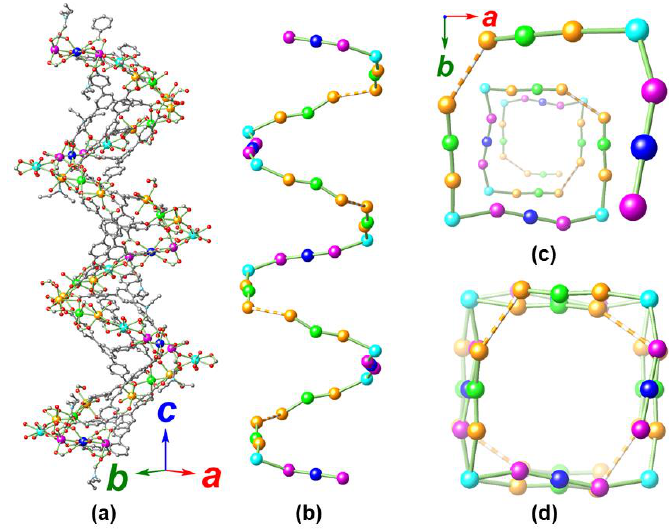
Figure 5. Structures of MOF 1 showing a helical chain propagating along the c direction assisted by the BTB ligands ( a ), skeleton structure with only metals ( b ), and the perspective ( c ) and parallel ( d ) views of the helical chain along the c direction. Dashed bonds are used in ( b – d ) to indicate imaginary connections between Cd1 and its equivalents to facilitate understanding of the structure. All disordered components, dissociated DEF solvate, and hydrogen atoms are omitted for clarity. Color legend: C: gray, N: light blue, O: red, Cd1 / Cd2: orange, Cd3: magenta, Ca1: green, Ca2: cyan, Ca3: blue. The BTB ligand skeletons and coordinated DEF in ( a ) are further distinguished by gray for clarity.